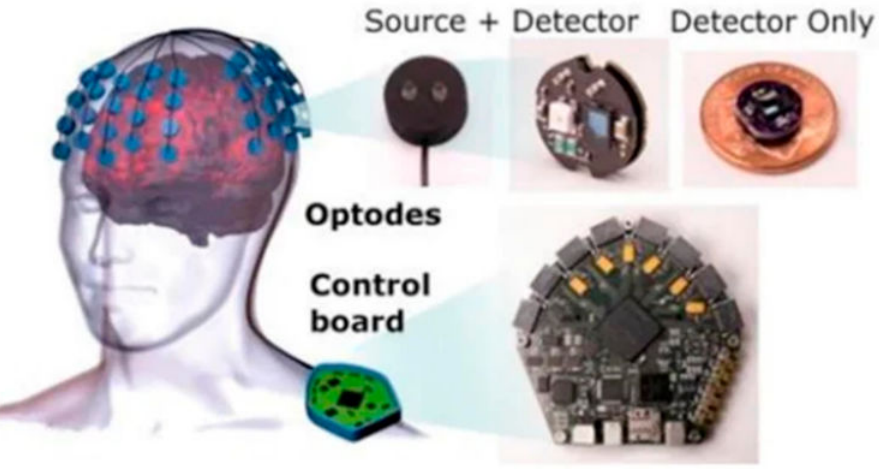
Figure 13. An example of the equipment needed for a fNIRS-BCI system. The hardware can be modular and non-invasive, important for the daily use of the user. (Reprinted from [44]).